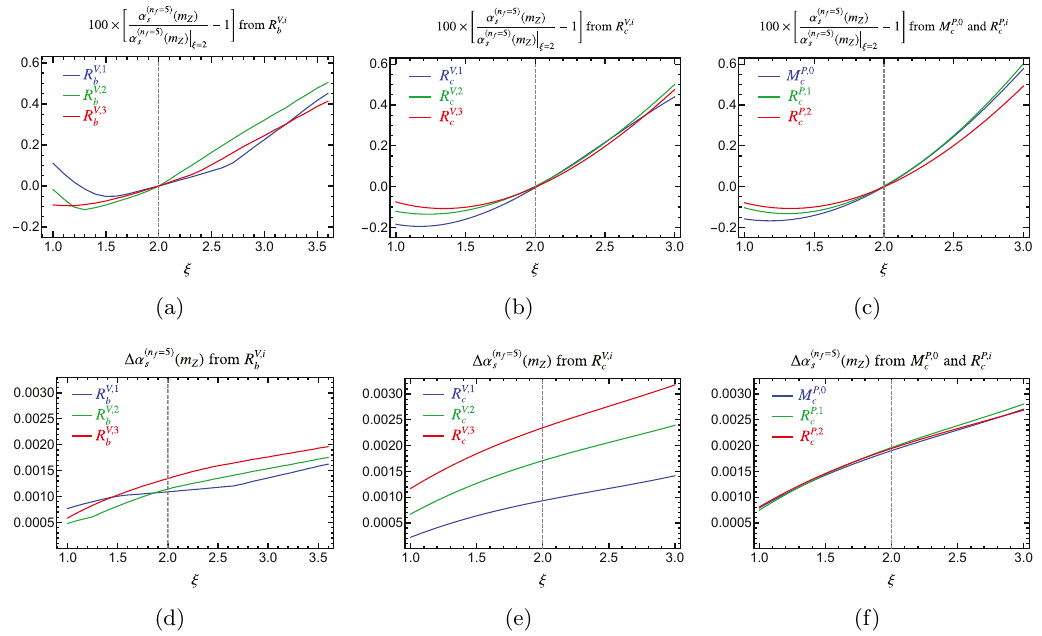
Figure 2 . Dependence of the central value and perturbative uncertainty with the \trim- ming" parameter (cid:24) , which controls how renormalization scales are varied through the constraint 1 =(cid:24) (cid:20) (cid:22) (cid:11) =(cid:22) m (cid:20) (cid:24) , with m q (cid:20) (cid:22) (cid:11) ; (cid:22) m (cid:20) (cid:22) max and q = c ( b ) for charm (bottom). The gray, dashed, vertical lines signal our canonical choice (cid:24) = 2. The three panels on top correspond to how central values depend on (cid:24) , shown as a percent deviation from our canonical choice for (cid:24) . The three panels at the bottom show the dependence of perturbative uncertainties with (cid:24) . Left, right, and middle panels correspond to bottom vector, charm vector, and charm pseudo-scalar, respectively. Blue, red and green distinguish which moment or ratio is used, as shown in the plot